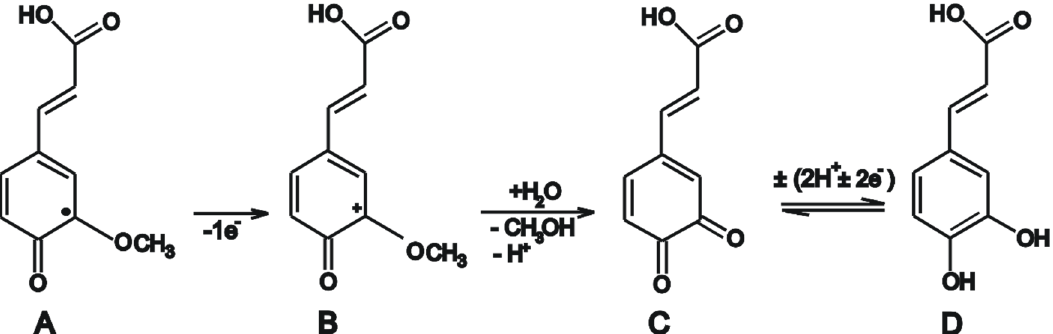
Figure 1. Cyclic voltammogram carbon nanofiber modified screen-printed electrode (CNF/SPE) immersed in 10 − 3 M ferulic acid solution and 10 − 1 M PBS at 0.1 V/s: first (red line) and second scan (black line).